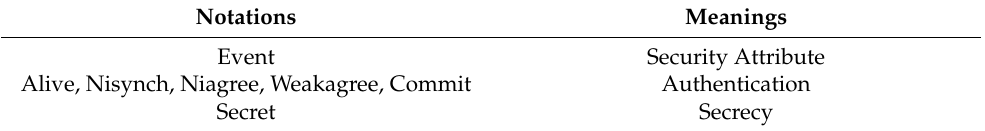
Table 4. Claim event